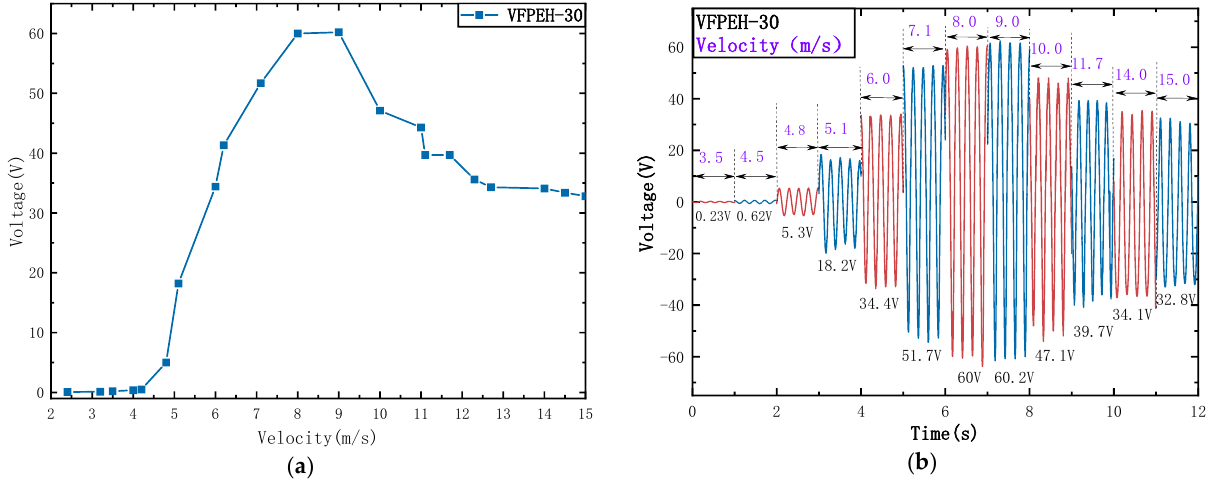
Figure 10. Output characteristics of the VFPEH-30: ( a ) Output voltage curve at different wind velocities; ( b ) Output voltage waveform.